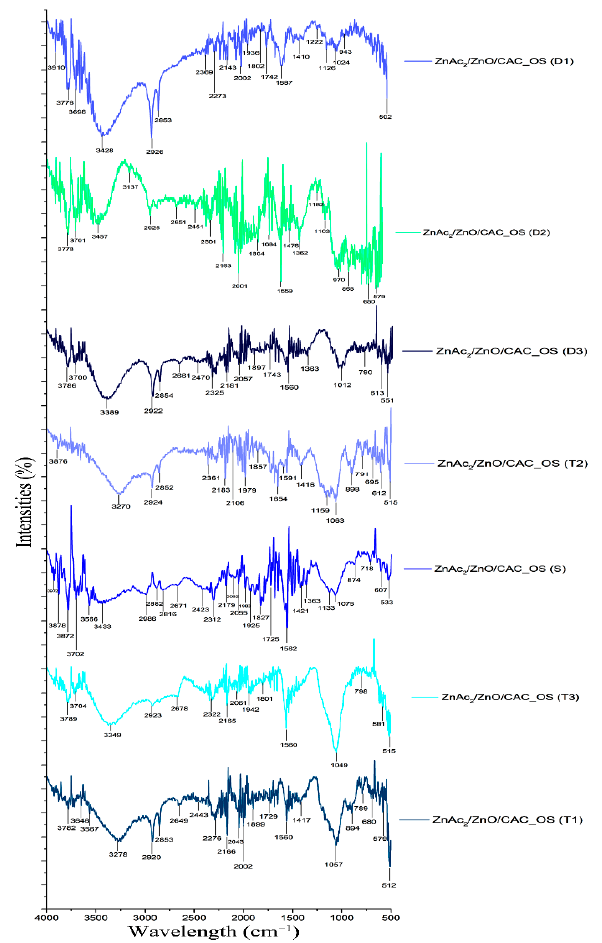
Figure 6. FTIR spectra of ZnAc 2 /ZnO/CAC_DCM through three H 2 S adsorption–desorption cycles. Adsorbents that have adsorbed gas under saturated circumstances (T1, T2 and T3) can be found in a variety of functional groups when compared with fresh adsorbents,